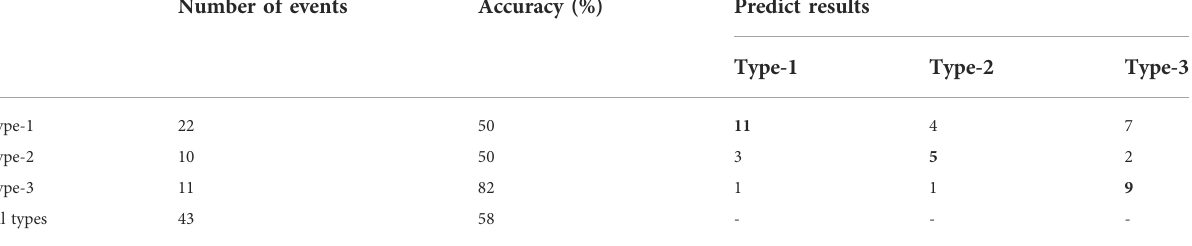
TABLE 3 Accuracy of prediction. The bold font indicates successfully predicted